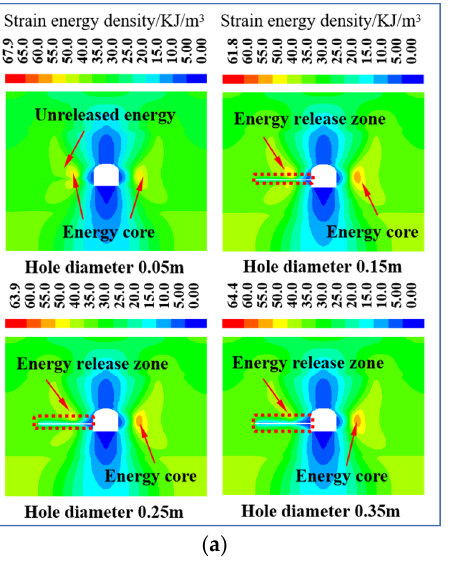
Figure 6. Energy release characteristics of the large-diameter borehole with different hole diameters. ( a ) Evolution characteristics of the strain energy contour plot with different diameters. ( b ) Evolution characteristics of the strain energy density curves with different diameters.